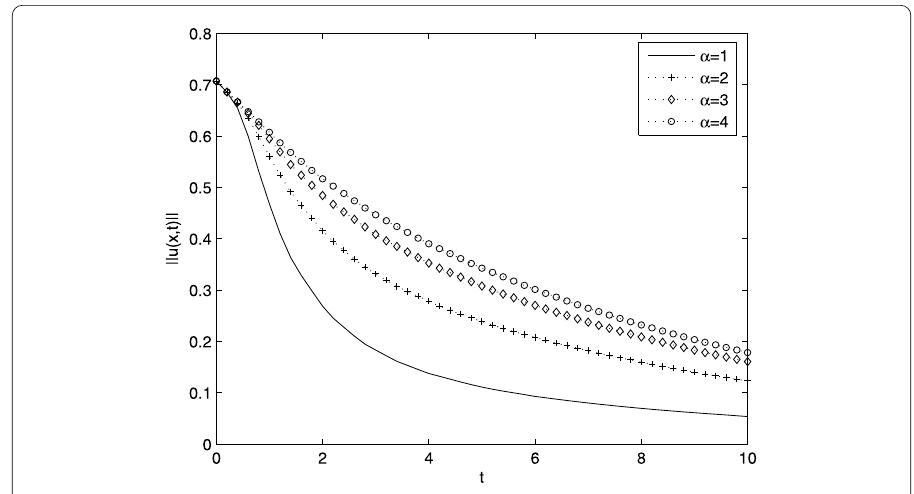
Figure 2 The L 2 -norm of u ( x , t ), (cid:7) u ( x , t ) (cid:7) , versus time for various values of α when using the first nonlinear